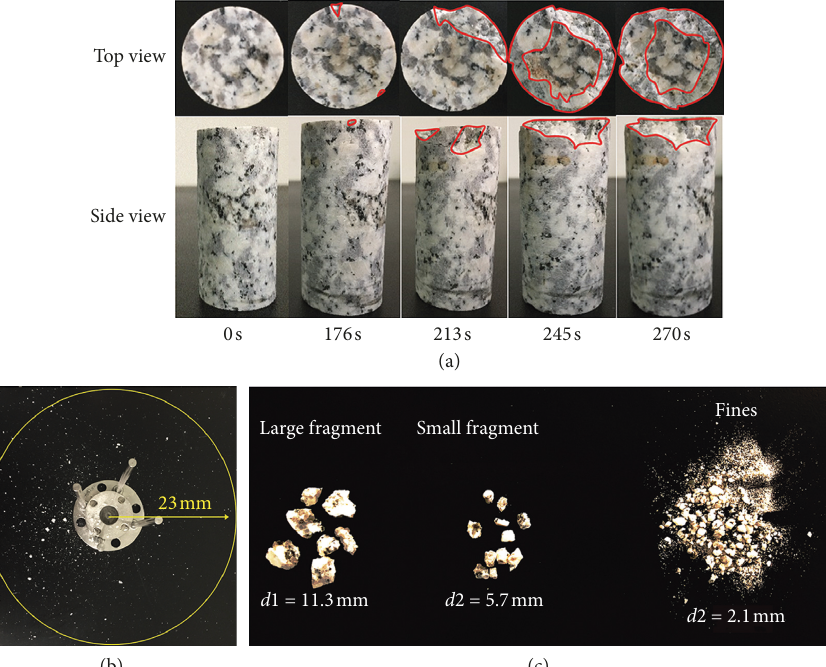
Figure 6: Fracture mode of the samples. (a) Destruction process of samples (the red line area represents the destruction area). (b) Injection radius. (c) Fragments size distribution (the numbers mean the average sizes of three types of fragments).